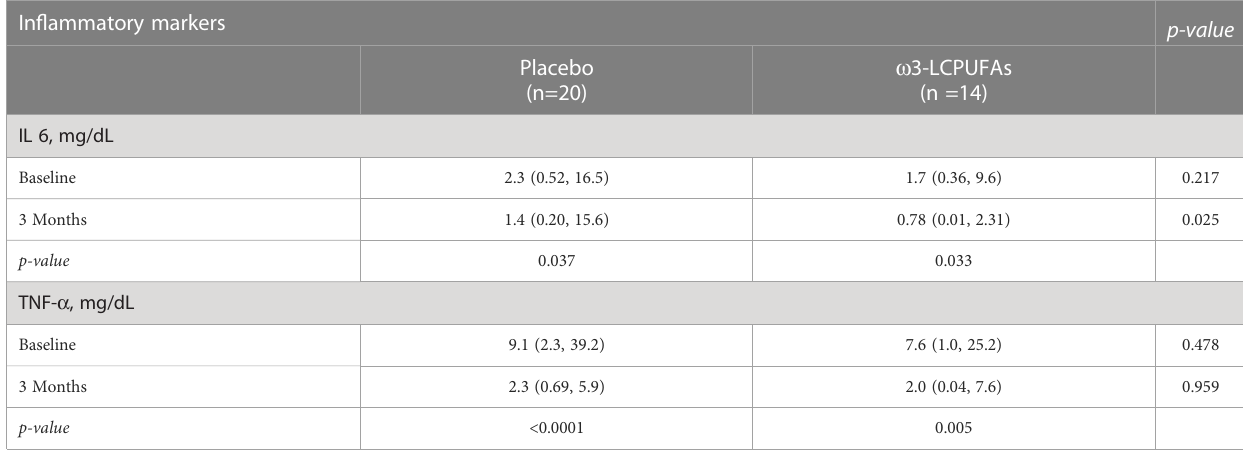
TABLE 3 In fl ammatory markers in children with acute lymphoblastic leukemia from baseline and three months of supplementation with placebo or w 3-LCPUFA capsules. In fl ammatory